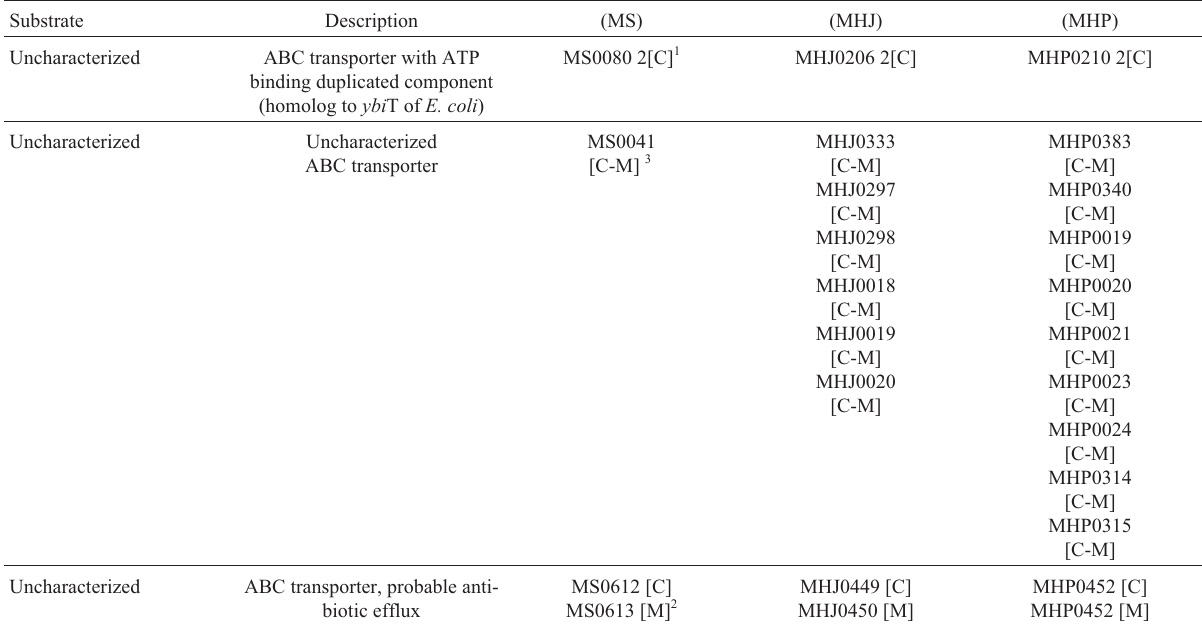
Table 4 - Description of CDSs related to uncharacterized ABC transporter in the M. synoviae strain 53 (MS) and M. hyopneumoniae strains J (MHJ) and 7448 (MHP) genomes